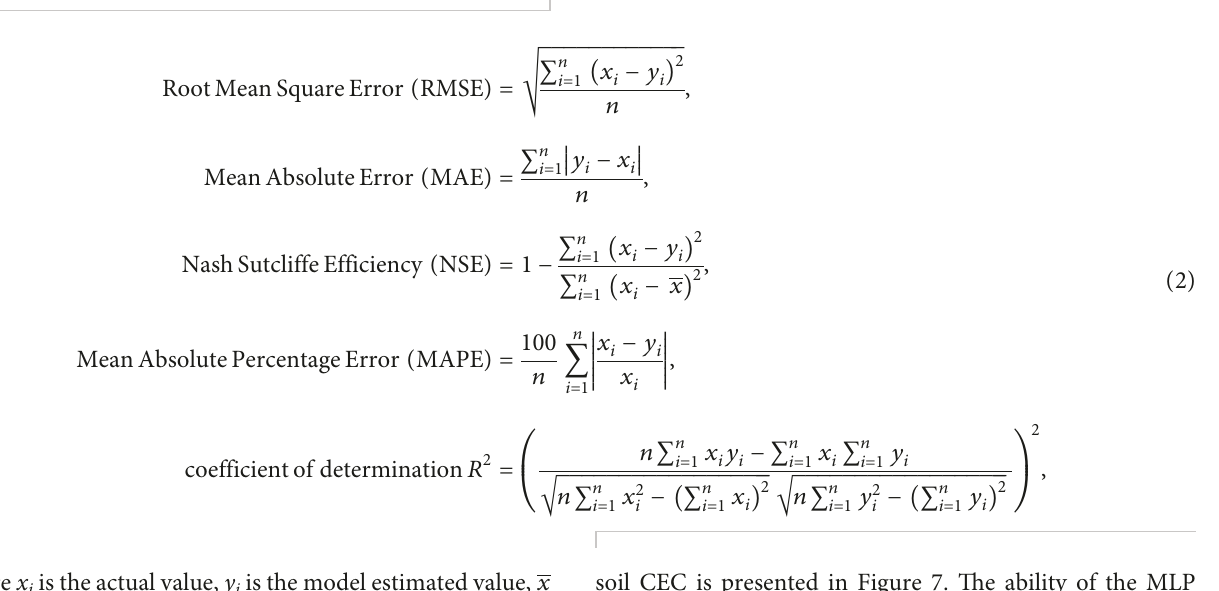
Table 2. The model structure (input nodes-hidden layer nodes-output nodes) and performance metrics of the ANN model for each input combination are presented in Table 3.